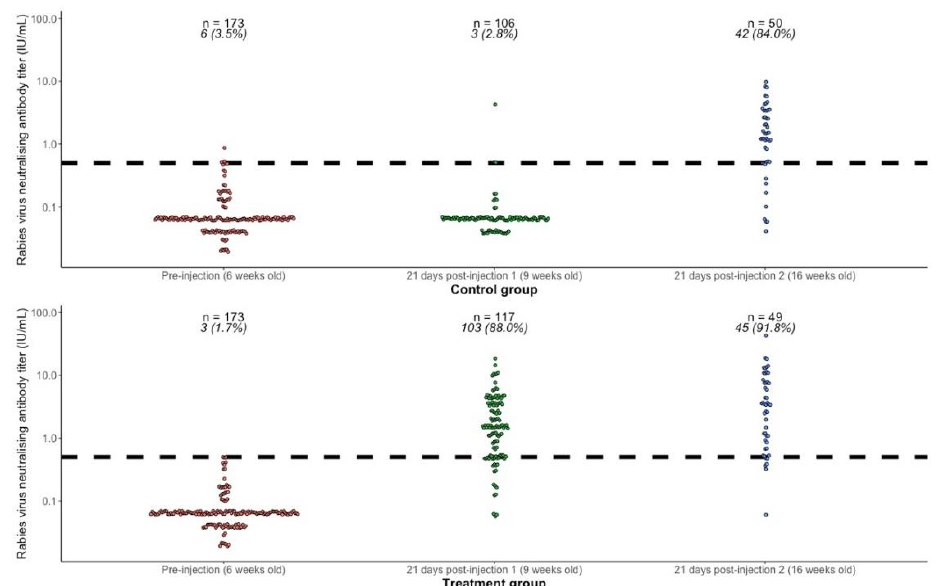
Figure 2. Rabies virus neutralizing antibody titers (RVNA) in the treatment and control groups at 6 weeks of age (prevaccination), 21 days after first injection at 9 weeks of age (rabies vaccine in the treatment group and sterile water in the control group), and 21 days after second injection at 13 weeks of age (rabies vaccine in both groups). The dashed horizontal line shows the threshold of seroprotection (0.5 IU / mL). The numbers above each group show the number of subjects ( n ) and the number and percentage (%) seroresponding (RVNA titers ≥ 0.5 IU / mL).